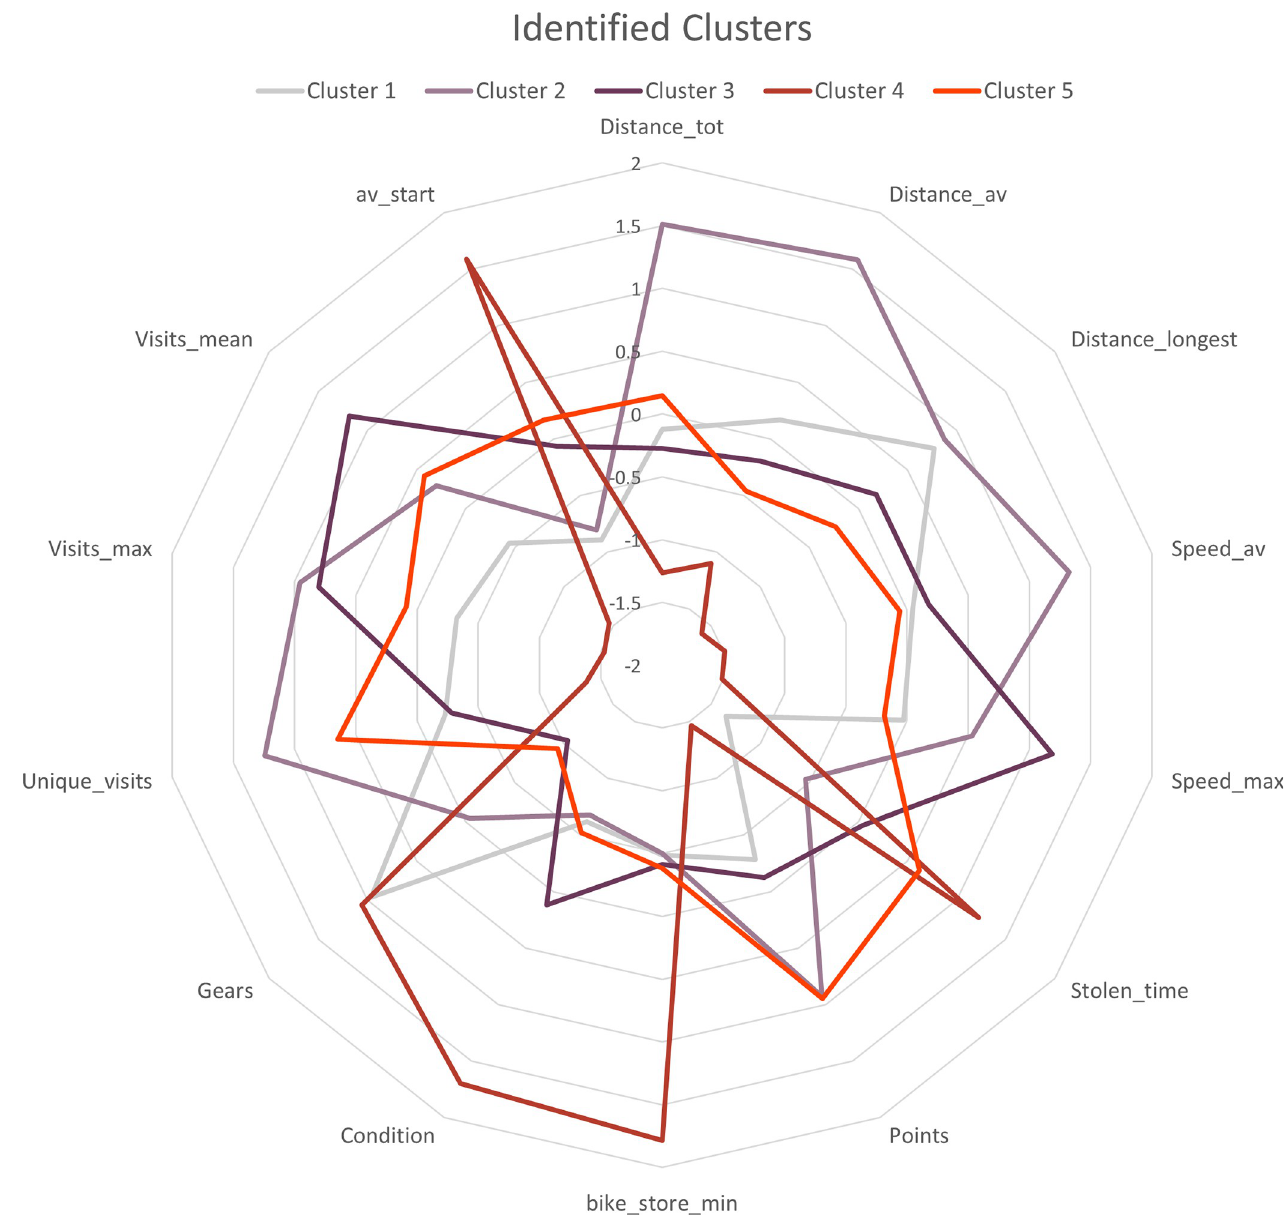
Fig 14. Hierarchical clustering results, visualized as the deviation of the cluster from the overall mean providing information about the differences between all